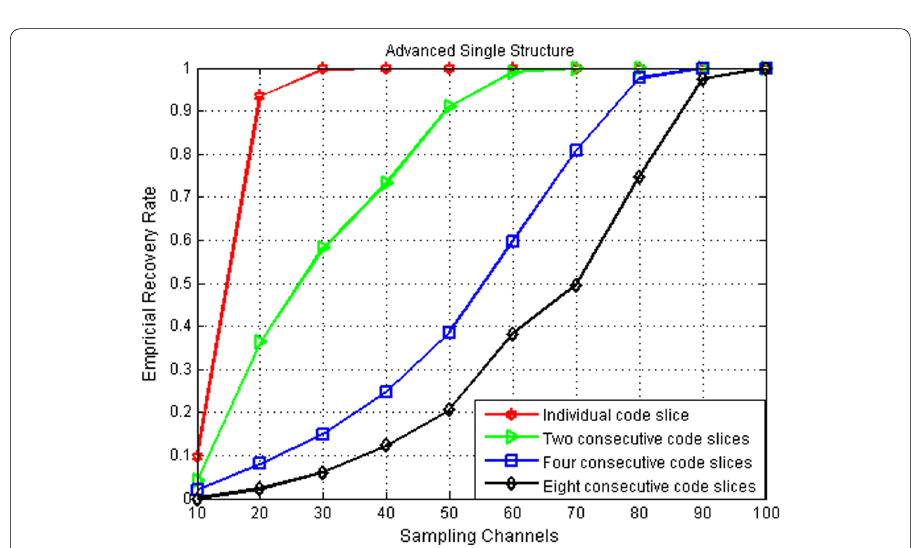
Fig. 16 Percentage of correct support recovery in ADS, when SNR